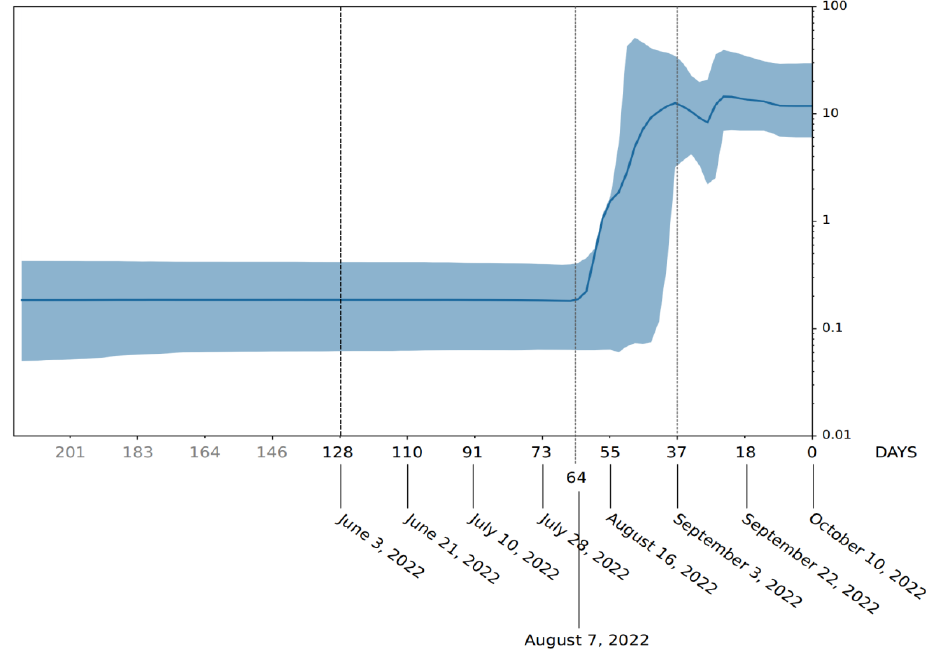
Figure 3. Bayesian skyline plot of SARS-CoV-2 BQ.1 variant. The viral effective population size (y-axis) is shown as a function of days (x-axis). The solid area represents the 95% high posterior density (HPD) region.